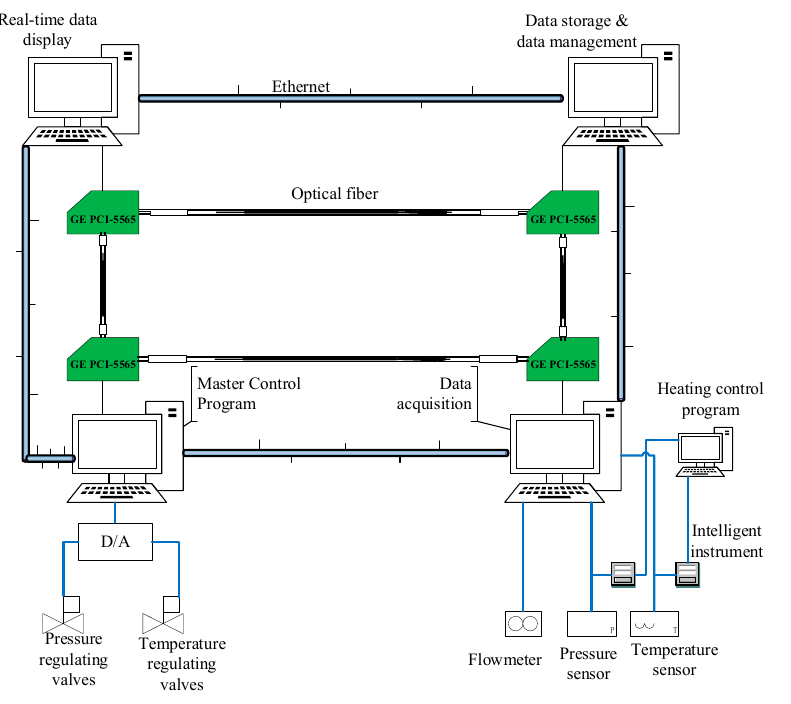
Figure 7. Structure diagram of the TT&C system.